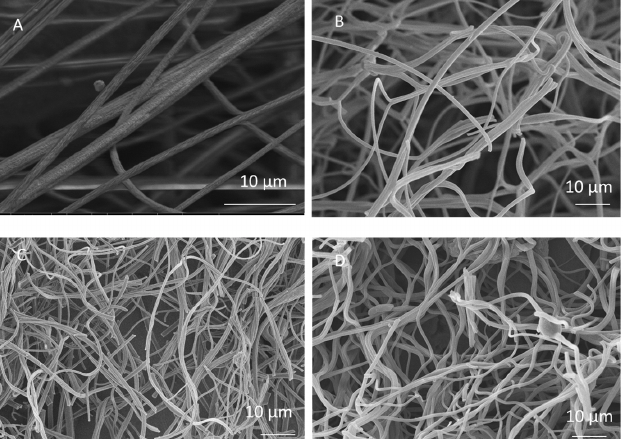
Figure 1. SEM images of ( A ) PAN nanofibers and carbon nanofibers carbonized at ( B ) 700 °C ( C ) 800 °C, and ( D ) 900 °C. After spinning, PAN nanofibers are converted to CNFs by applying a two-step thermal treatment that includes stabilization and carbonization. In the stabilization process, the nanofibers are heated in air at 280 °C for 3 h. During this time, the chemical structure of PAN was changed to a ladder structure with cyclization, dehydrogenation, aromatization, oxidation, and crosslinking reactions occurring in the air atmosphere. Crosslinking occurs with the formation of triazine, which is the result of an intermolecular reaction involving three nitriles of three different PAN chains to prevent decomposition at high temperatures. Intermolecular and intramolecular nitrile crosslinking reactions are crucial for determining the final structure because these reactions change the chemical structure of PAN to form a ladder-like structure due to cyclization of the nitrile groups and thus determine the structure of the CNFs. An incomplete stabilization process leads to poor carbon properties. Following stabilization, PAN was carbonized in a N 2 atmosphere at 700 °C, 800 °C, and 900 °C for 2 h to form polyaromatic (graphite structure) and disordered carbons (turbostratic structure). The carbonization process includes an aromatic growth and polymerization step, in which the noncarbon elements are removed as volatile gases in the form of hydrogen, nitrogen, water, ammonia, and so on [18,19]. SEM images of the CNFs carbonized at temperatures of 700 °C, 800 °C, and 900 °C are shown in Figure 1B–D. The average diameters of the CNFs were 930, 888, and 850 nm at 700 °C, 800 °C, and 900 °C, respectively. The average diameter of the nanofibers decreased after the carbonization process due to the removal of noncarbon elements during carbonization and decreased distances between the flat sheets of carbon [20]. In addition to reduced fiber diameters, a rough fiber surface was observed due to the presence of an amorphous structure and defects, which are beneficial for ion diffusion and increased contact area between the electrode and the electrolyte. With increasing carbonization temperature, most of the functional groups such as the nitrile group were eliminated, which led to a decrease in the average diameter of the fibers. Similar results were reported in previous studies. Lee et al. synthesized electrospun PAN-based activated CNFs and reported that the diameter of fibers decreased from 670 nm to 640 nm as the carbonization temperature increased from 800 °C to 950 °C [21]. Munajat et al. investigated the effects of carbonization temperature on the morphology of nanofibers produced by electrospinning and reported that the average diameter of CNFs decreased from 658.80 nm to 352.40 nm as the carbonization temperature increased from 800 °C to